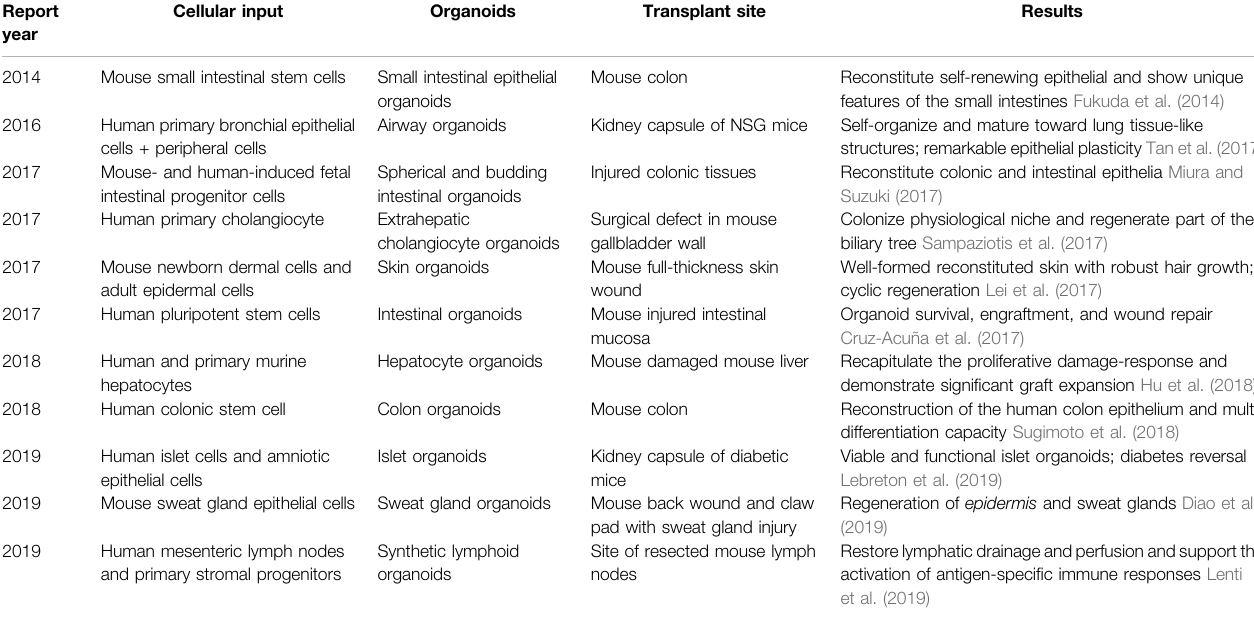
TABLE 3 | Organoids used regenerative medicine